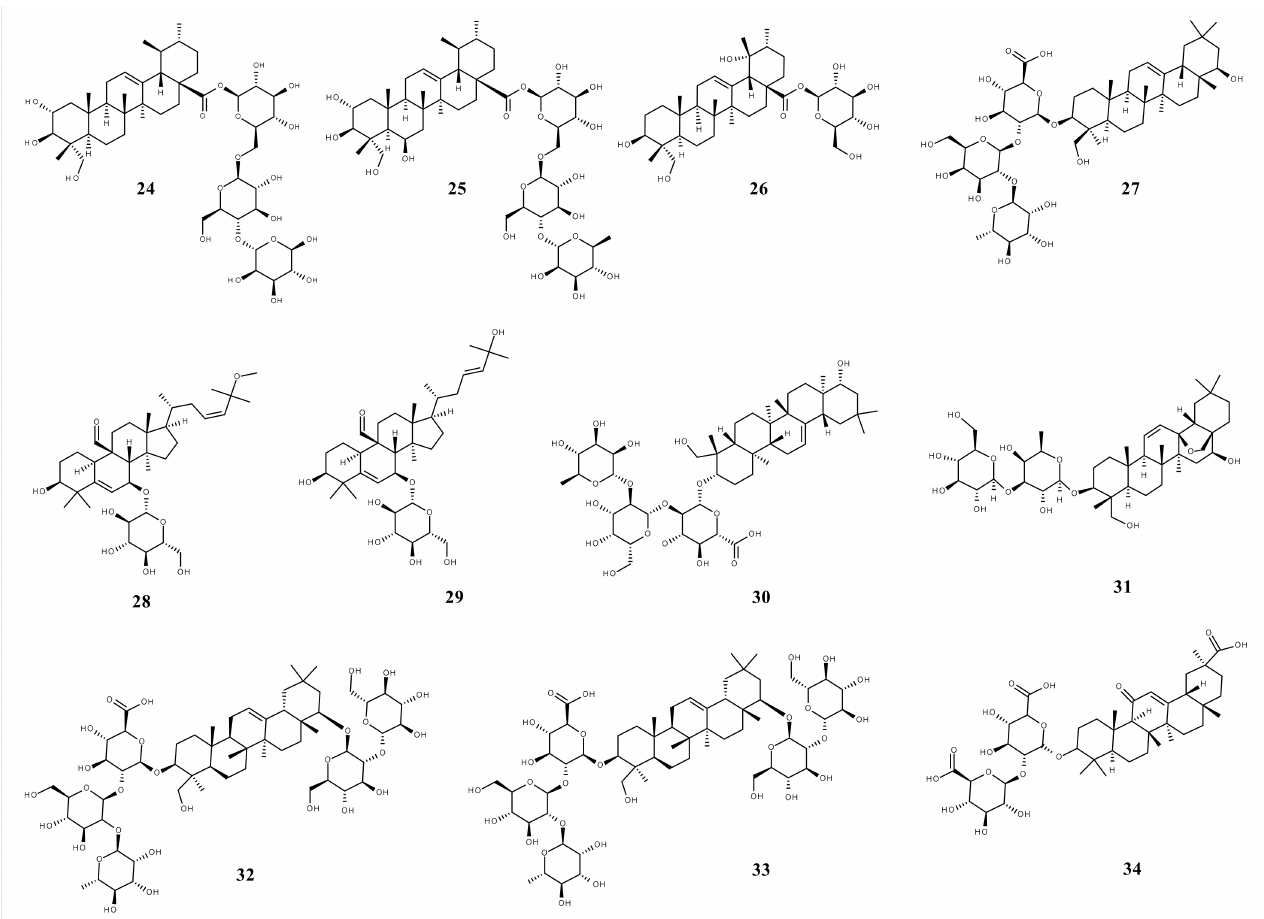
Figure 1. The chemical structure of several triterpenic saponins: Asiaticoside ( 24 ), Madecassoside ( 25 ), Pedunculoside ( 26 ), Azukisaponin V ( 27 ), Momordicoside K ( 28 ), Momordicoside L ( 29 ), Soyasaponin I ( 30 ), Saikosaponin-D ( 31 ), Bersimoside I ( 32 ), Bersimoside II ( 33 ) and Glycyrrhizic acid ( 34